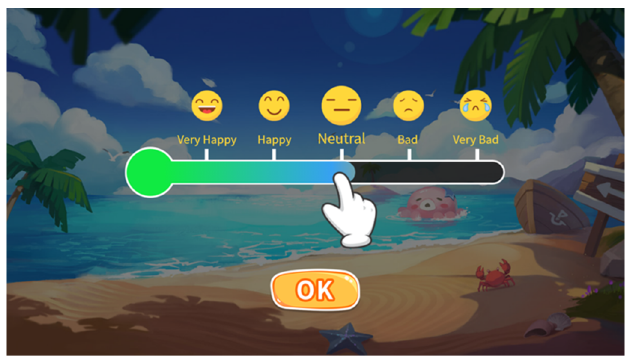
Figure 2. Screenshot of the mood tracker.